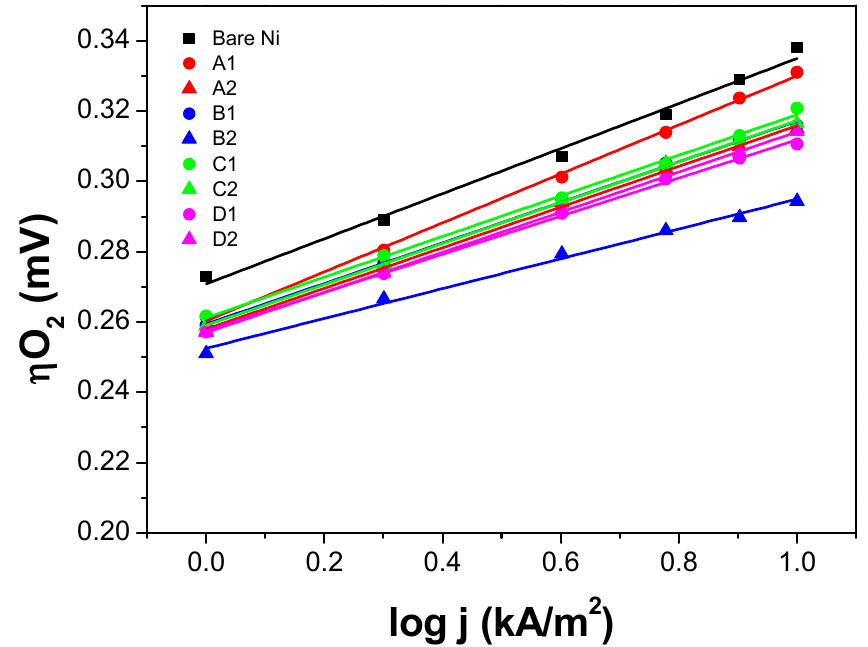
Figure 5. Electrochemical oxygen evolution reaction (OER) polarization curves of the NiO thin film electrodes (Tafel plots). The number after the letter corresponds to the pre-treatment of the Ni expanded mesh substrates: 1—sandblasted and acid etched; 2—not sandblasted but acid etched. The symbol (cid:4) corresponds to the bare / uncoated Ni expanded mesh.